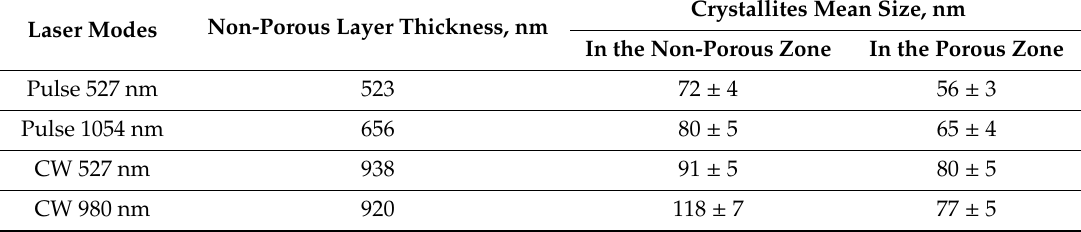
Table 2. Microstructure parameters from SEM images of silver NP arrays sintered by di ff erent types of laser radiation.